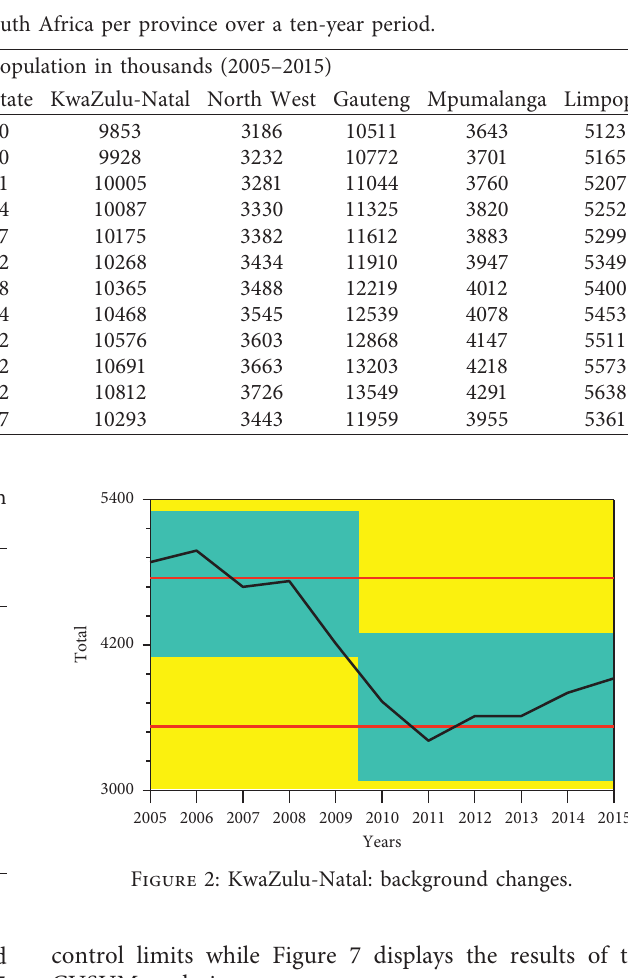
region. All points are within the control limits. In Figure 7, the CUSUM plot shows significant changes in the blue region. The CUSUM chart detects significant changes after 2012, and there is an ascending trend in the blue region.